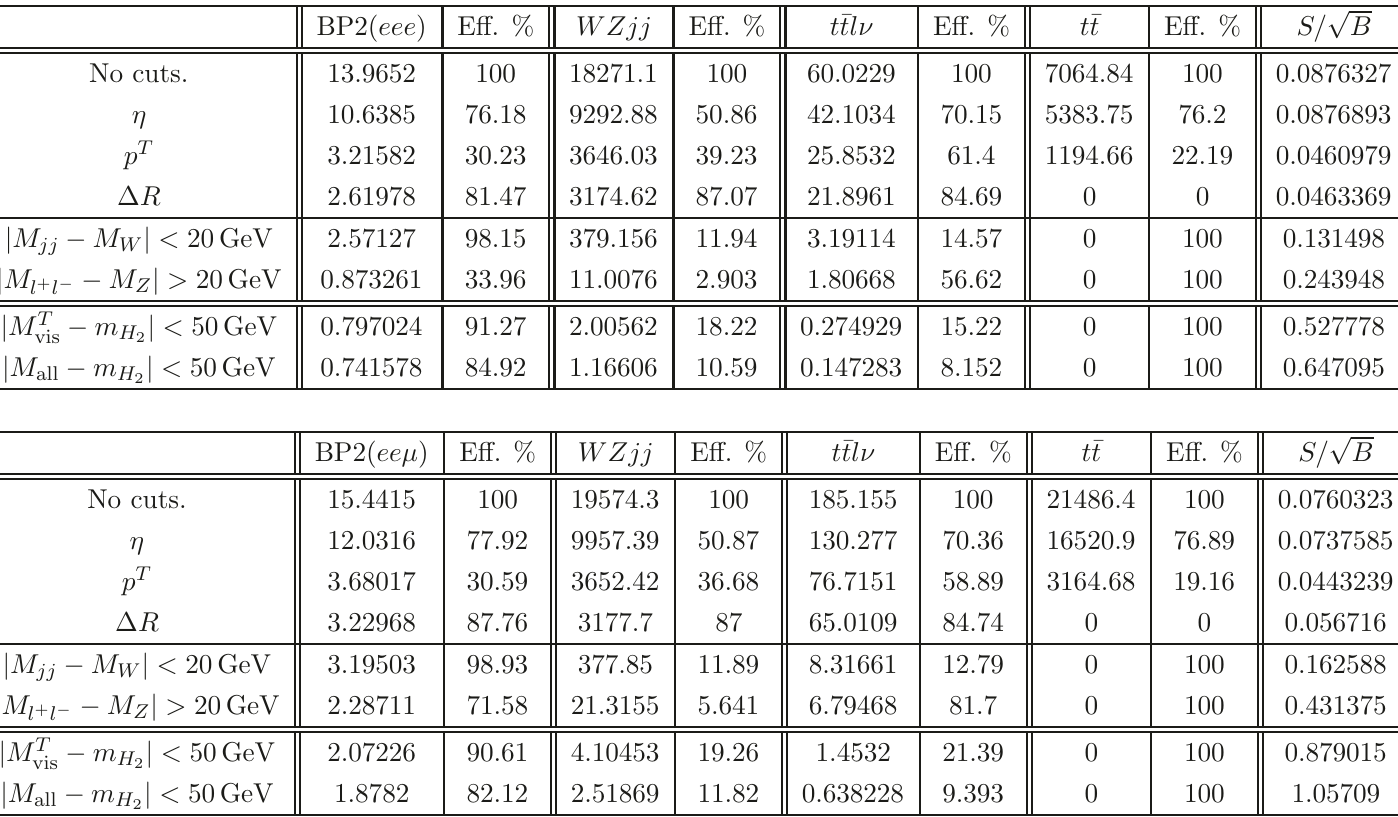
= 100fb − 1 . Universal acceptance cuts = L > 10 µ